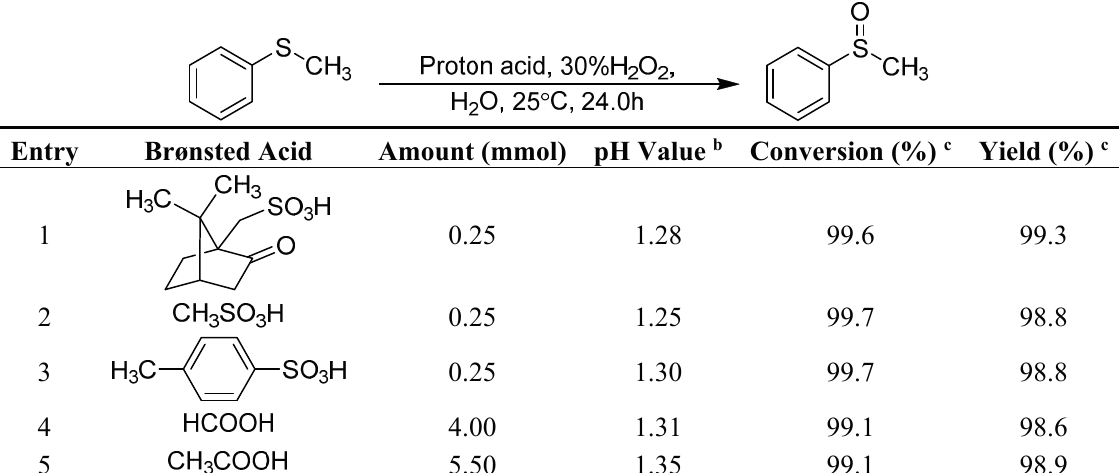
Table 2. Optimized amount of Brønsted acid-catalysts in the oxidation of methyl phenyl sulfide with H 2 O 2 a and the pH value of the aqueous reaction